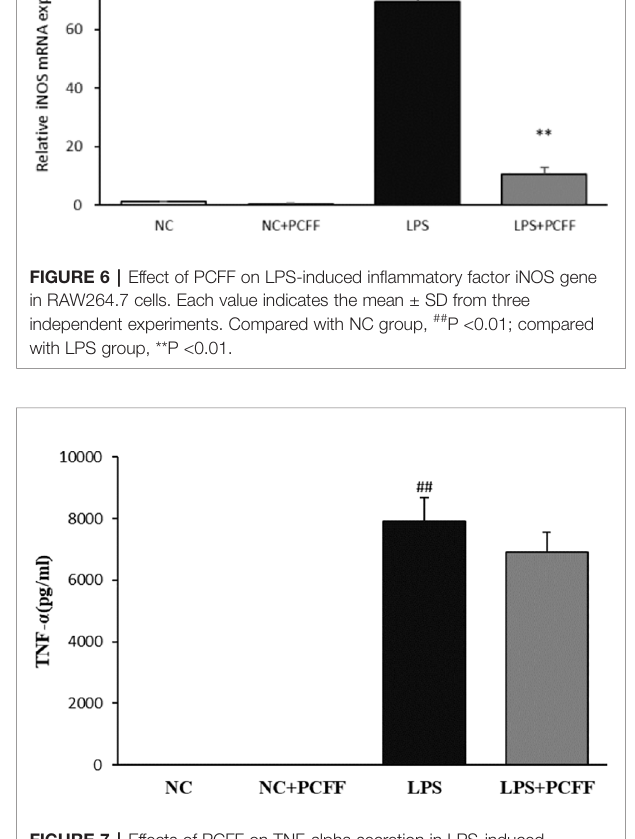
FIGURE 7 | Effects of PCFF on TNF-alpha secretion in LPS-induced RAW264.7 cells. Each value indicates the mean ± SD from three independent experiments. Compared with NC group, ## P < 0.01.